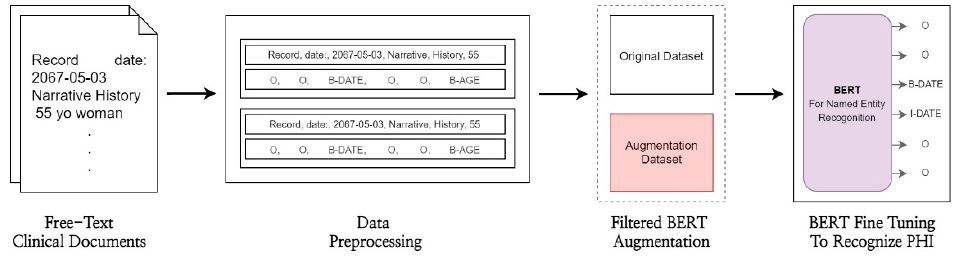
Figure 1. Filtered BERT augmentation data-pipeline.